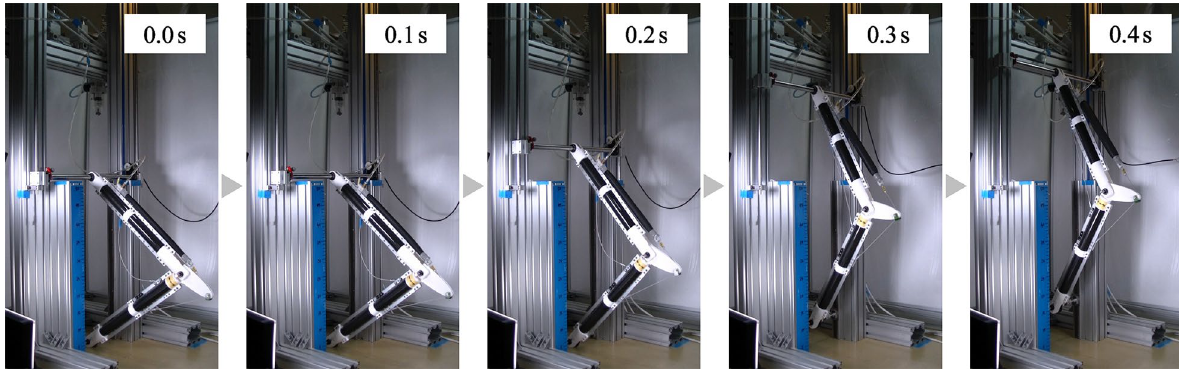
Fig. 14 Jumping motion of a leg-type robot with patella parameters of ( a , b , α) = ( 100,20,70 )